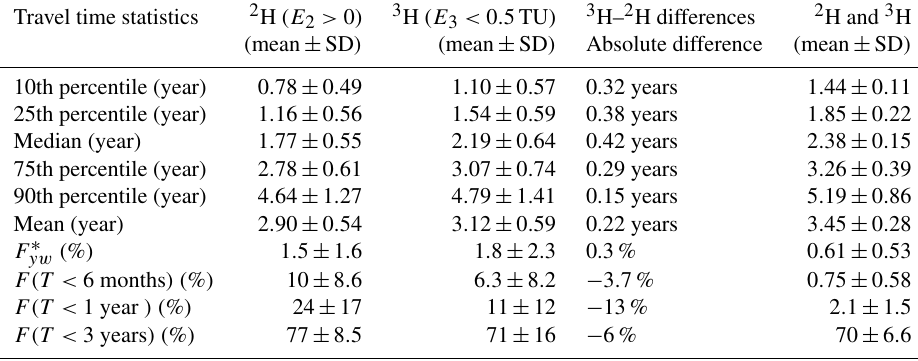
← P Q (T ) constrained by deuterium or tritium. Table 3. Statistics of